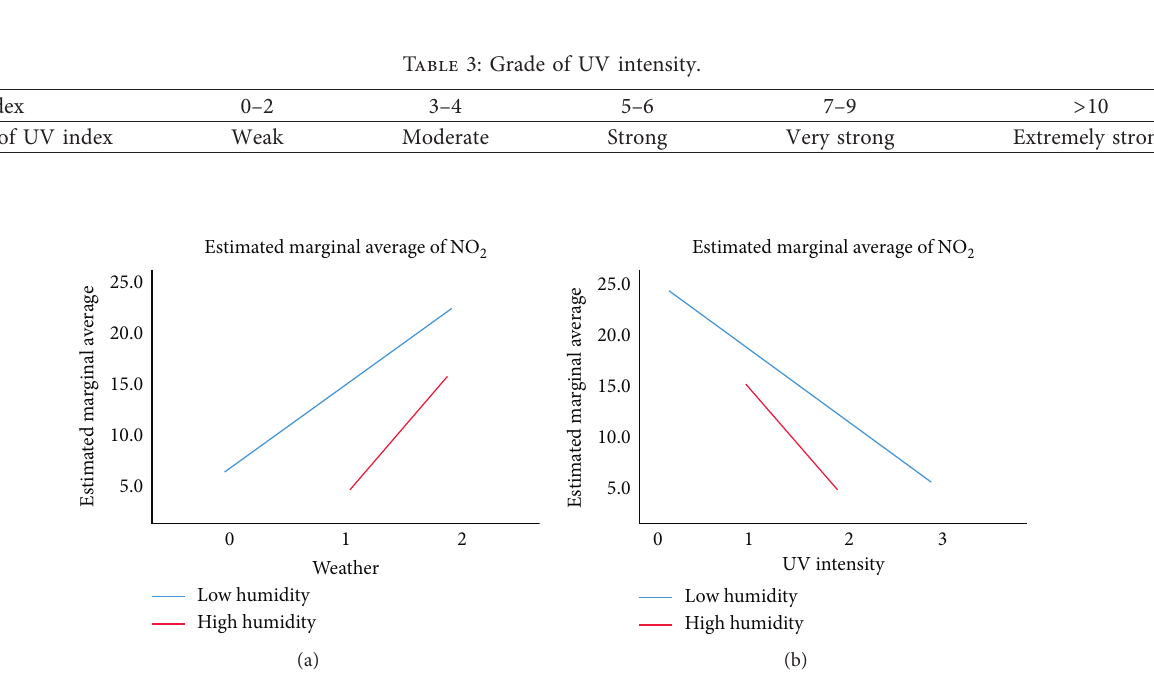
Figure 9: Influence of various factors on NO 2 degradation efficiency. (a) Humidity and weather factors on NO 2 degradation efficiency. (b) Humidity and UV intensity factors on NO 2 degradation efficiency. Table 4: Correlation coefficient of linear regression